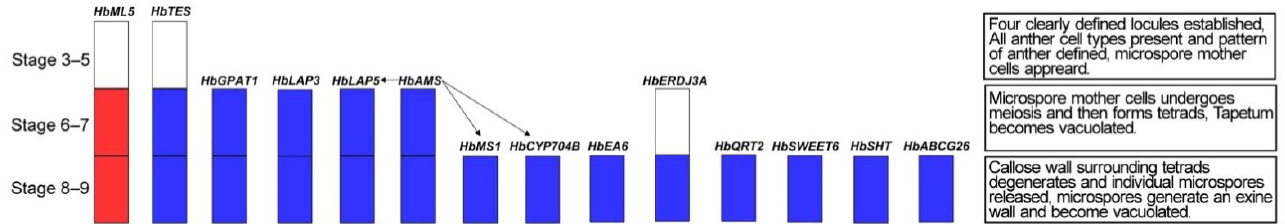
Figure 5. The expression pattern and relationship of the main 14 anther development–related or meiosis-related genes changed in female flowers. The blue boxes represent down-regulated gene expression, the red boxes represent up-regulated gene expression, and the white boxes represent insignificant changes in gene expression. The arrows show relationships between genes that have been known from previous studies.